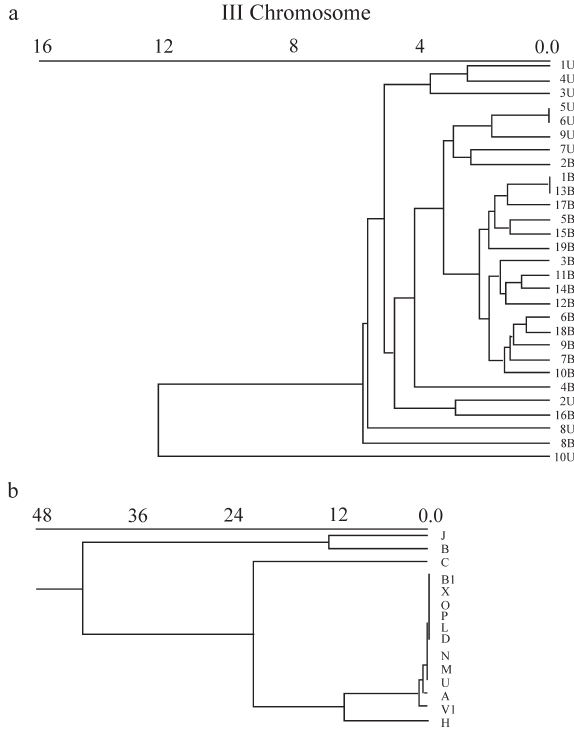
Figure 4 - Relationships among the D. willistoni populations from Uru- guay based on similarities/dissimilarities of chromosome III inversions using the UPGMA method. (a) Cluster based on the frequencies of hetero- zygous inversions in chromosome III and (b) the contribution of each type ofchromosomeIIIinversiontotheclusteringin(a).Populationsamplesas in Table 2, but see also Valente et al. (1993) and Appendix